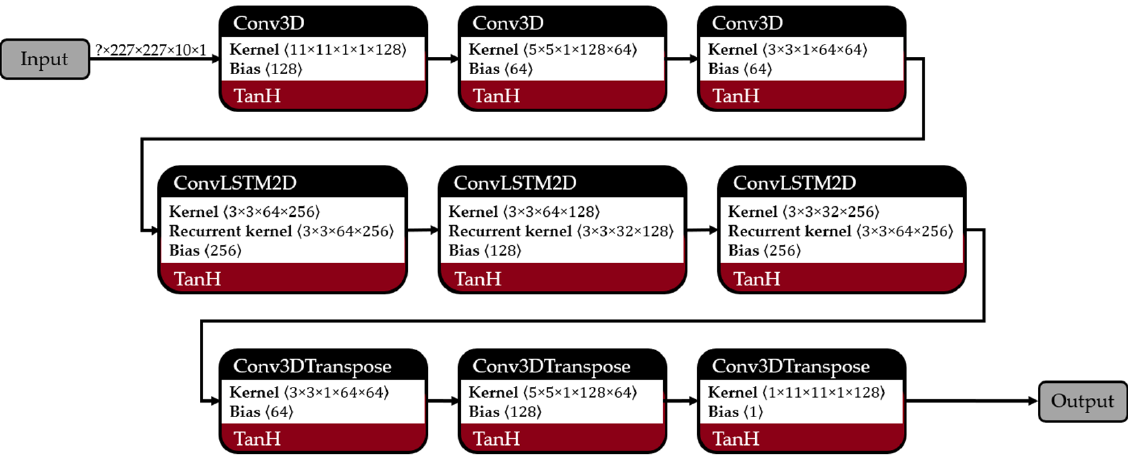
Figure 2. Structure of the individual autoencoders.